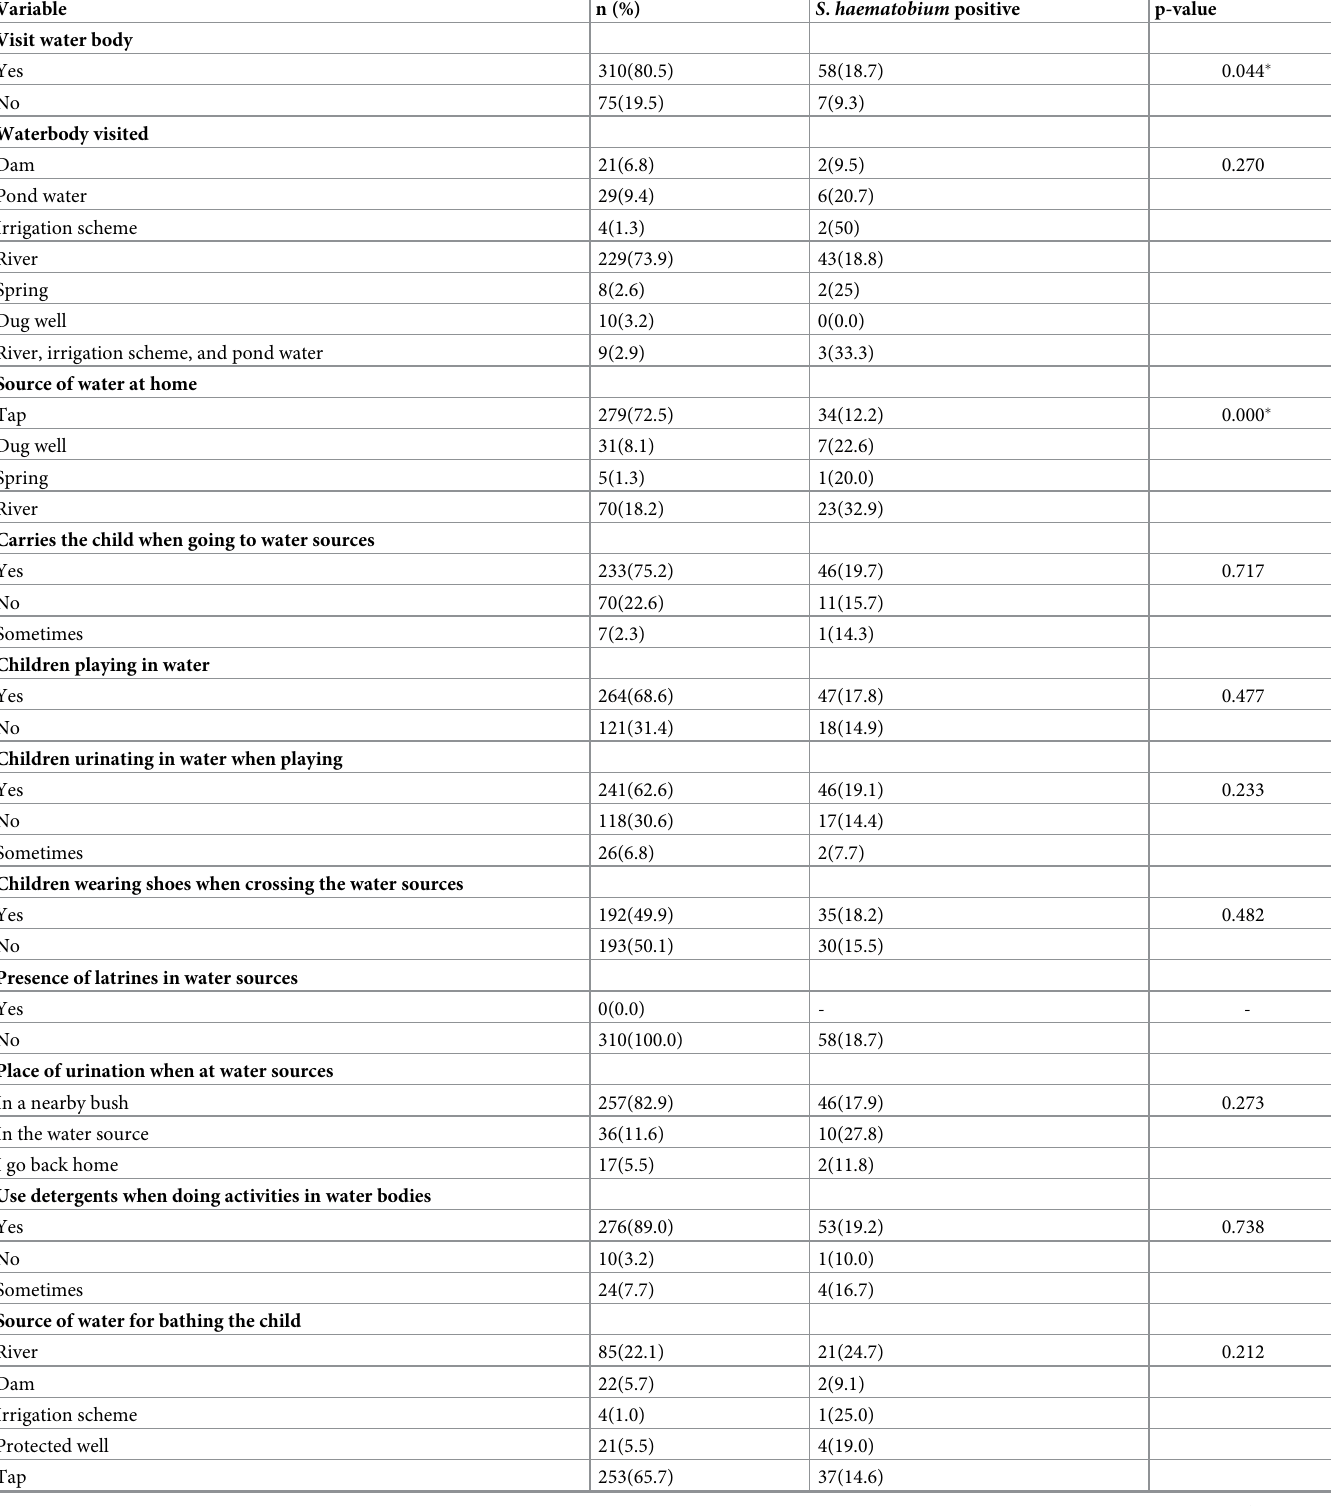
Table 6. Water, sanitation and hygiene status of the parents/guardians of the under-fives (n = 385).